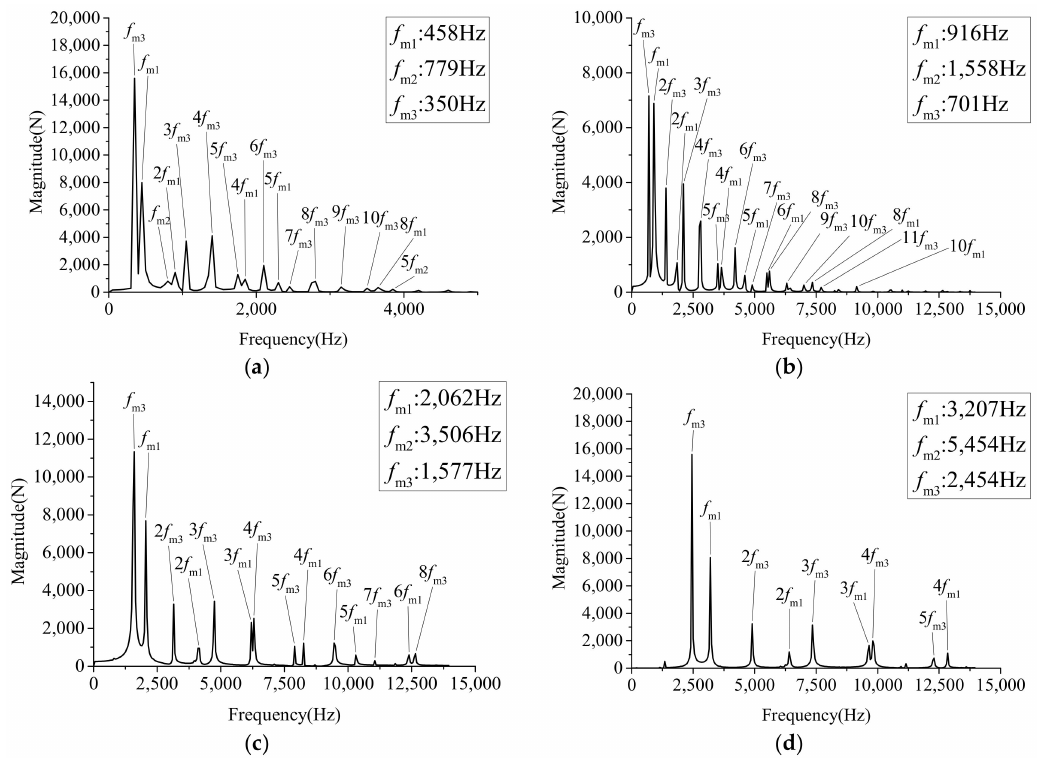
Figure 14. Spectrums diagram of meshing force of the third gear set at each input